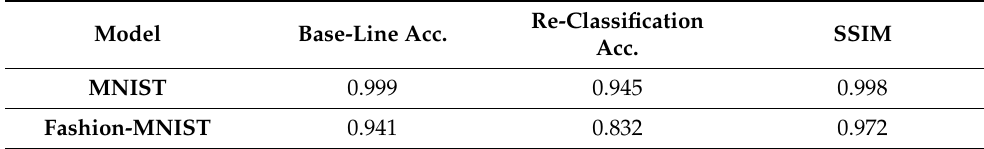
Table 5. Reclassification accuracy and SSIM of reconstruction attack results.